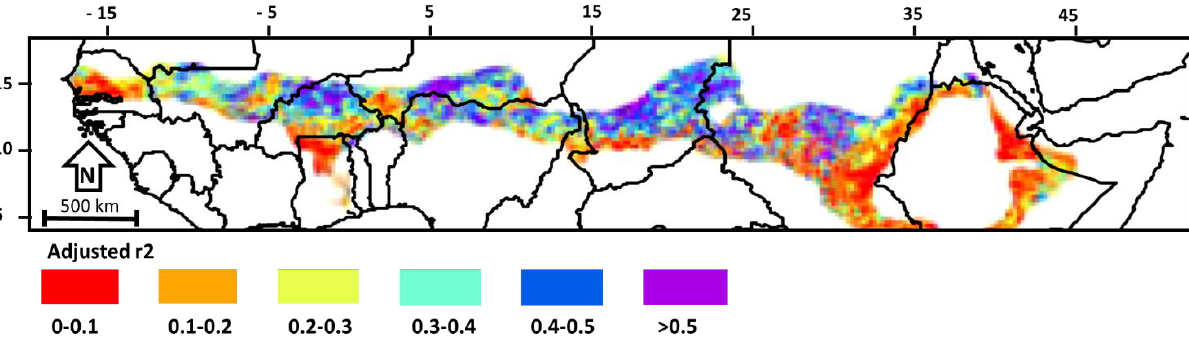
Figure 5. Spatial variation of multiple regression of annual summed GPCP (Global Precipitation Climatology Project) precipitation and annual mean air temperature on annual integrated